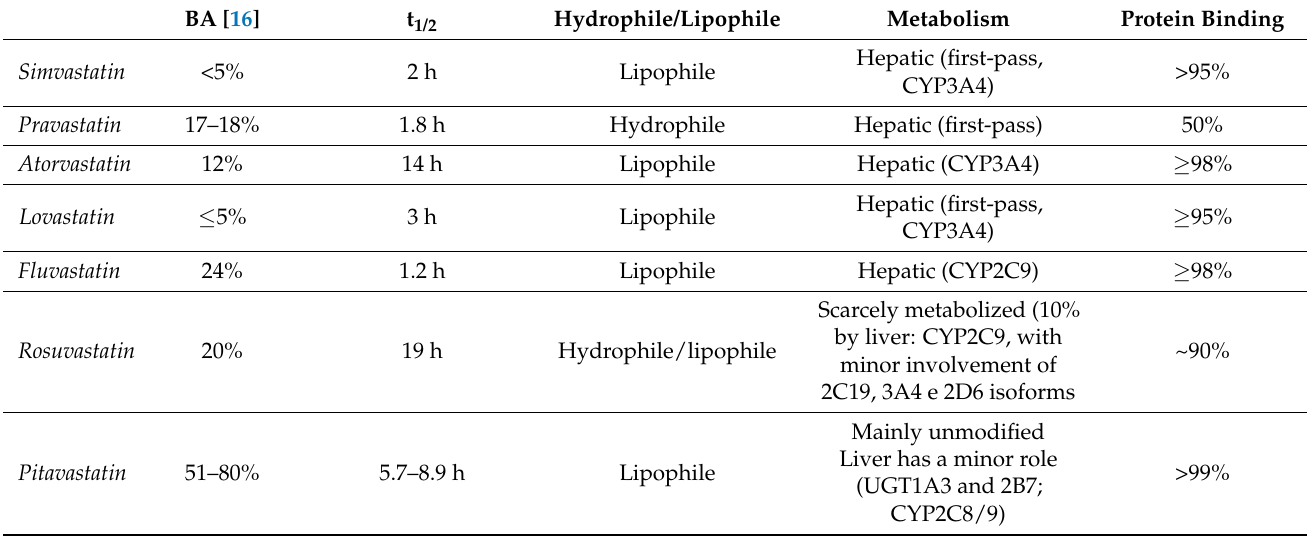
Table 1. Statins